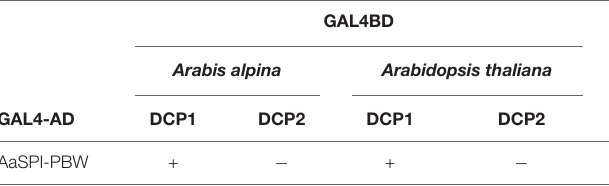
TABLE 5 | Yeast two-hybrid interaction between AaSPI-PBW and P-body components.